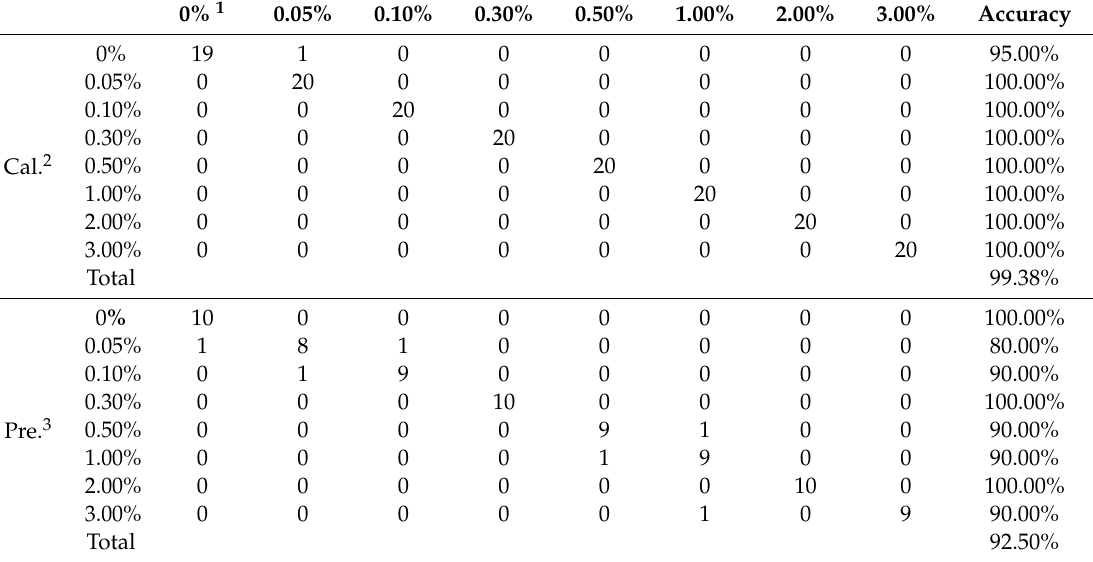
Table 5. Confusion matrix of SVM model based on the important wavelengths for classification the samples by the NIR-HSI